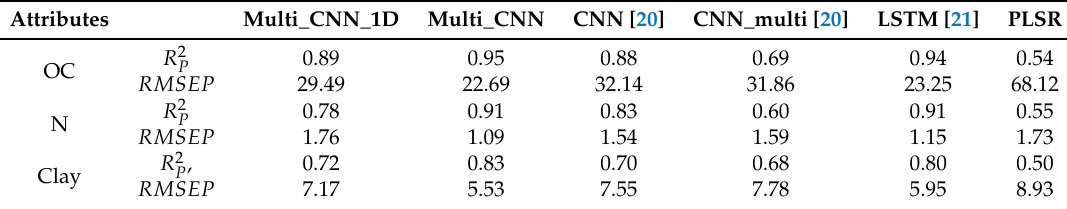
Table 4. Comparison of model evaluations on the LUCAS dataset.